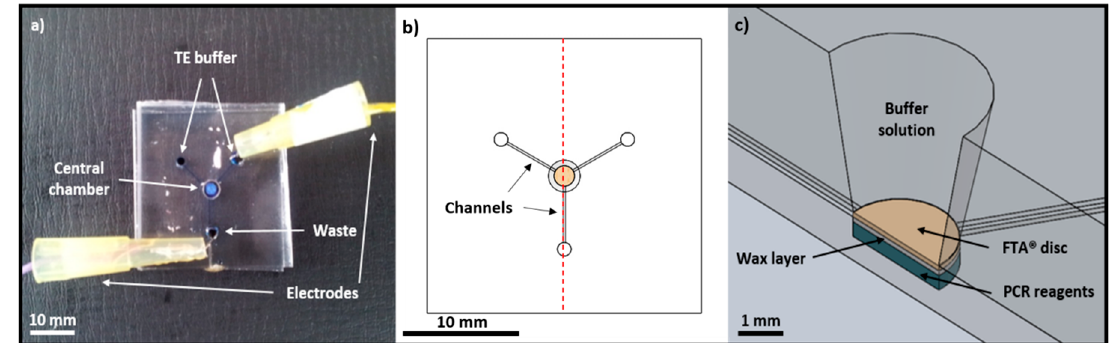
Figure 1. ( a ) Photograph showing the design of the microfluidic device used to perform integrated DNA purification and amplification experiments. The buffer wells are connected to the central chamber via 250-µm channels. ( b ) Schematic top-view showing the location of the channels, central chamber and reservoirs at the end of each channel. The dashed red line also indicates the cross-section view though which ( c ) occurs. (c) Schematic cross-section showing how the FTA ® paper discs are placed in the central chamber on top of a layer of wax-encapsulated PCR reagents.